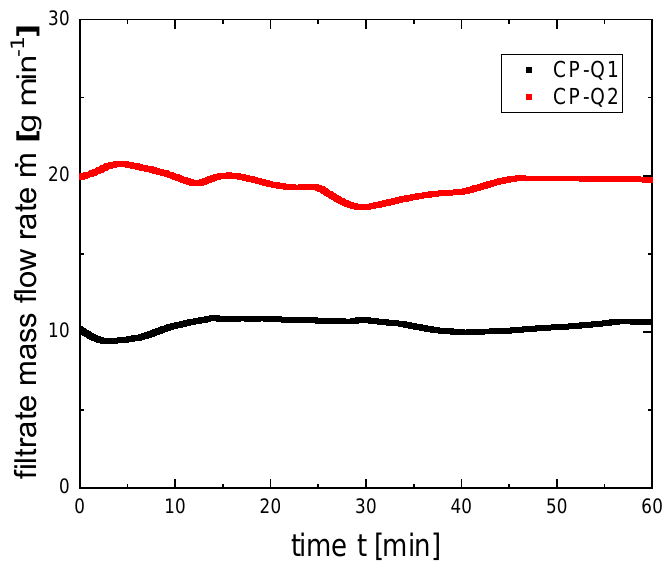
Figure 6. Mass flow rates during the experiment time of the filtrates of module A (filtration module) within the CVSF for experiments CP-Q1 and CP-Q2. t = 0 min is the time, when the first filtrate is obtained. Operating conditions as shown in Table 1.